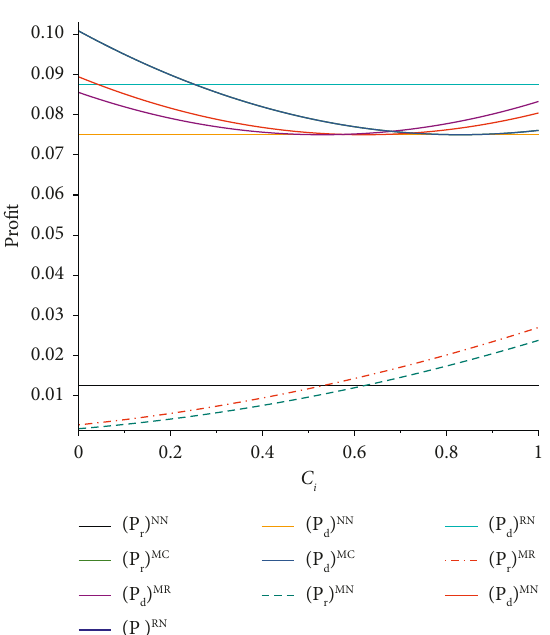
Figure 6: Effect of c